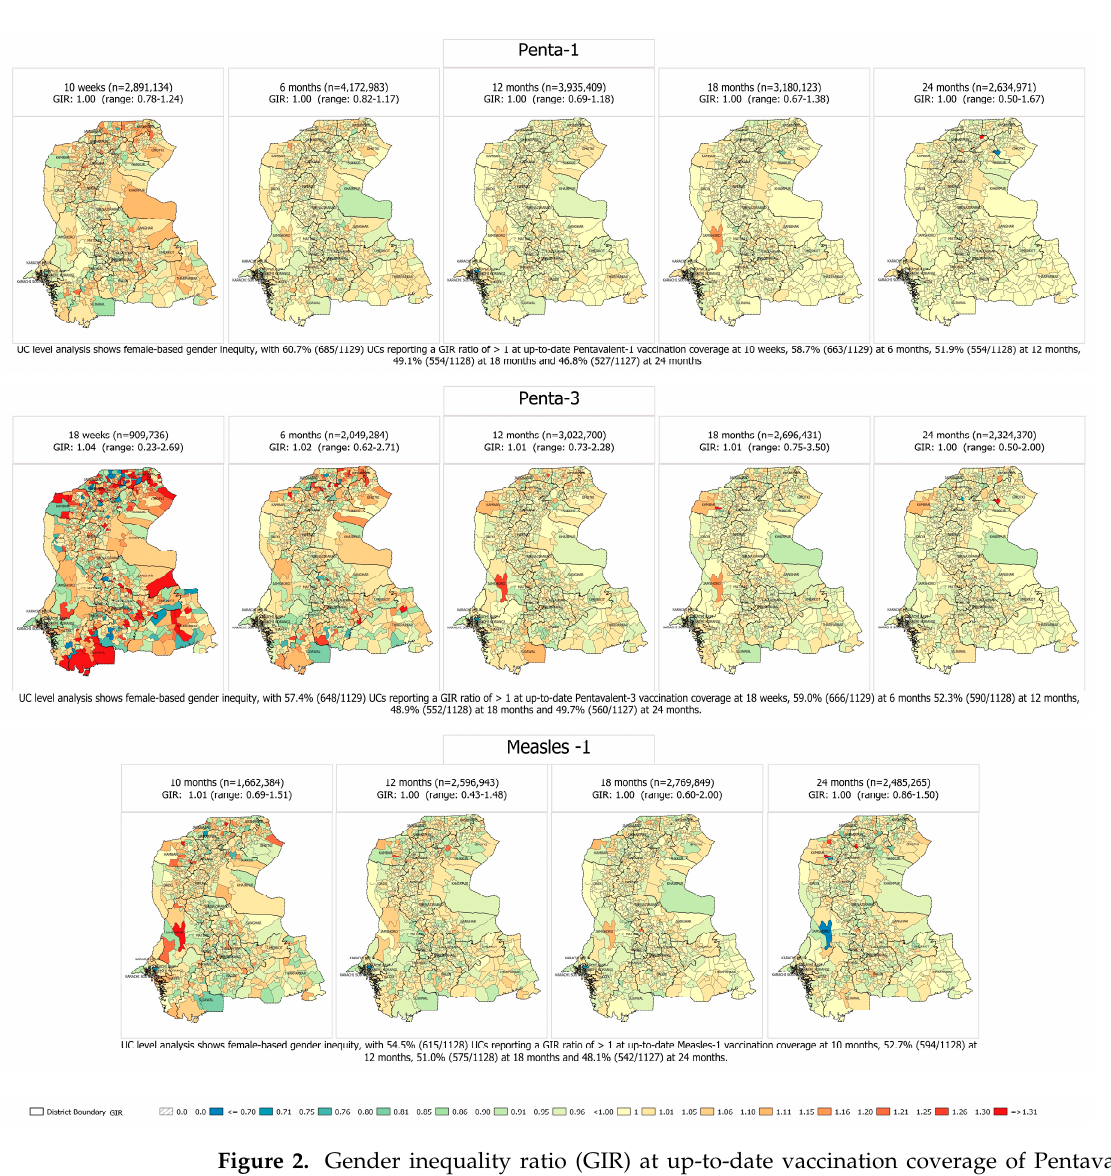
Figure 2. Gender inequality ratio (GIR) at up-to-date vaccination coverage of Pentavalent-1 at 10 weeks and 6, 12, 18, and 24 months; Pentavalent-3 at 18 weeks and 6, 12, 18, and 24 months; and